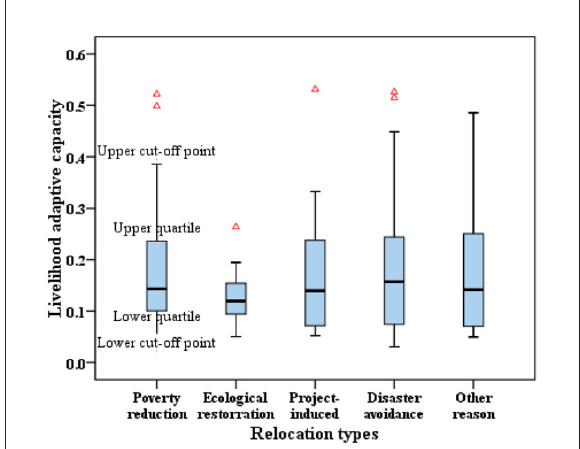
FIGURE1 The livelihood adaptive capacity index of different relocation types.